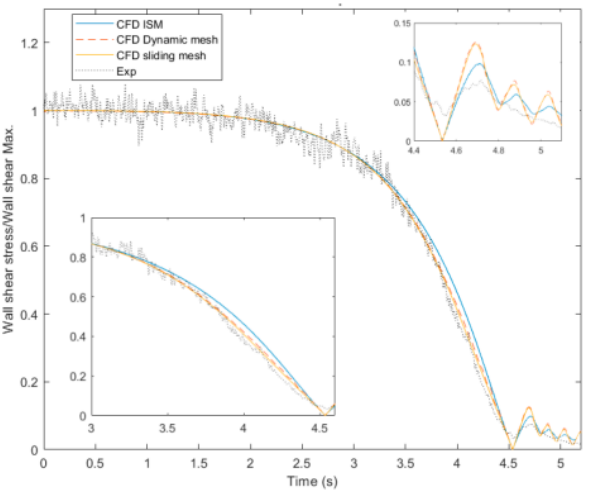
Figure 11. The time variation of the magnitude wall shear stress at cross-sections 10 m upstream of the valve.